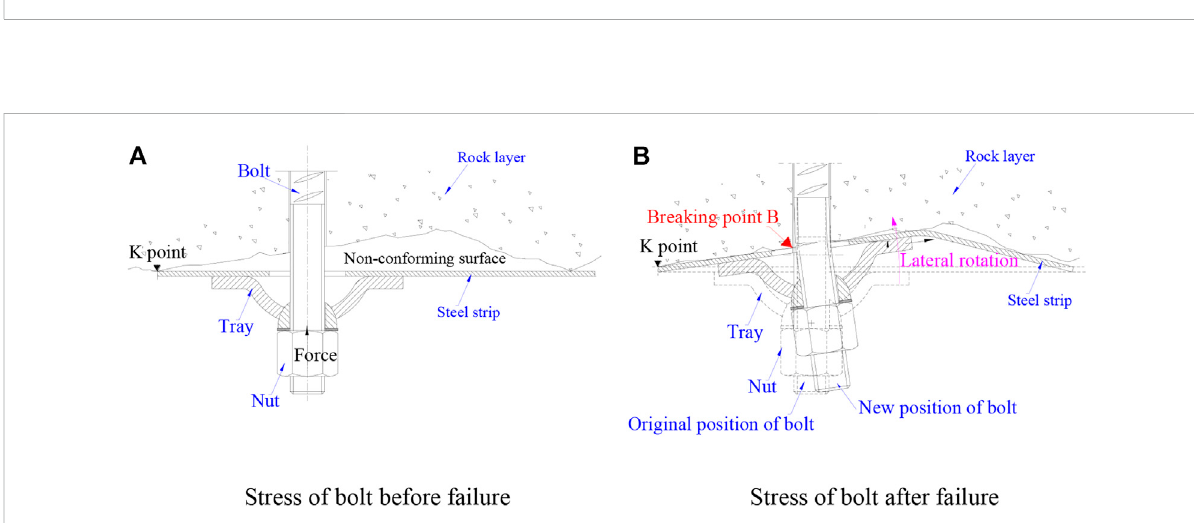
Frontiers in Earth